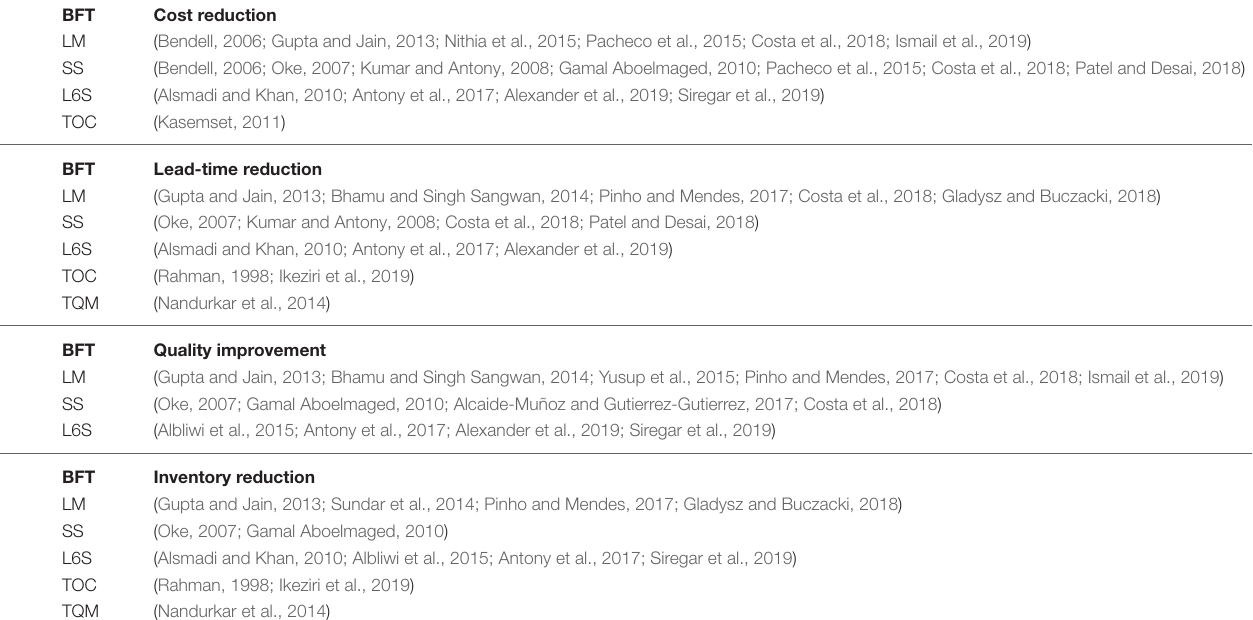
TABLE 3 | Top 10 benefits (BFT) identified in the articles